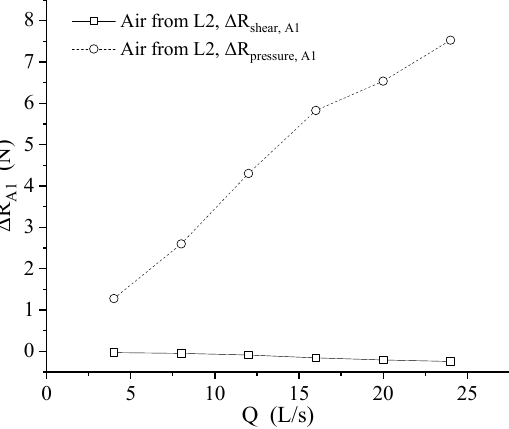
Figure 19. Changes in the resistance component of A1 with the air injected from location L2.